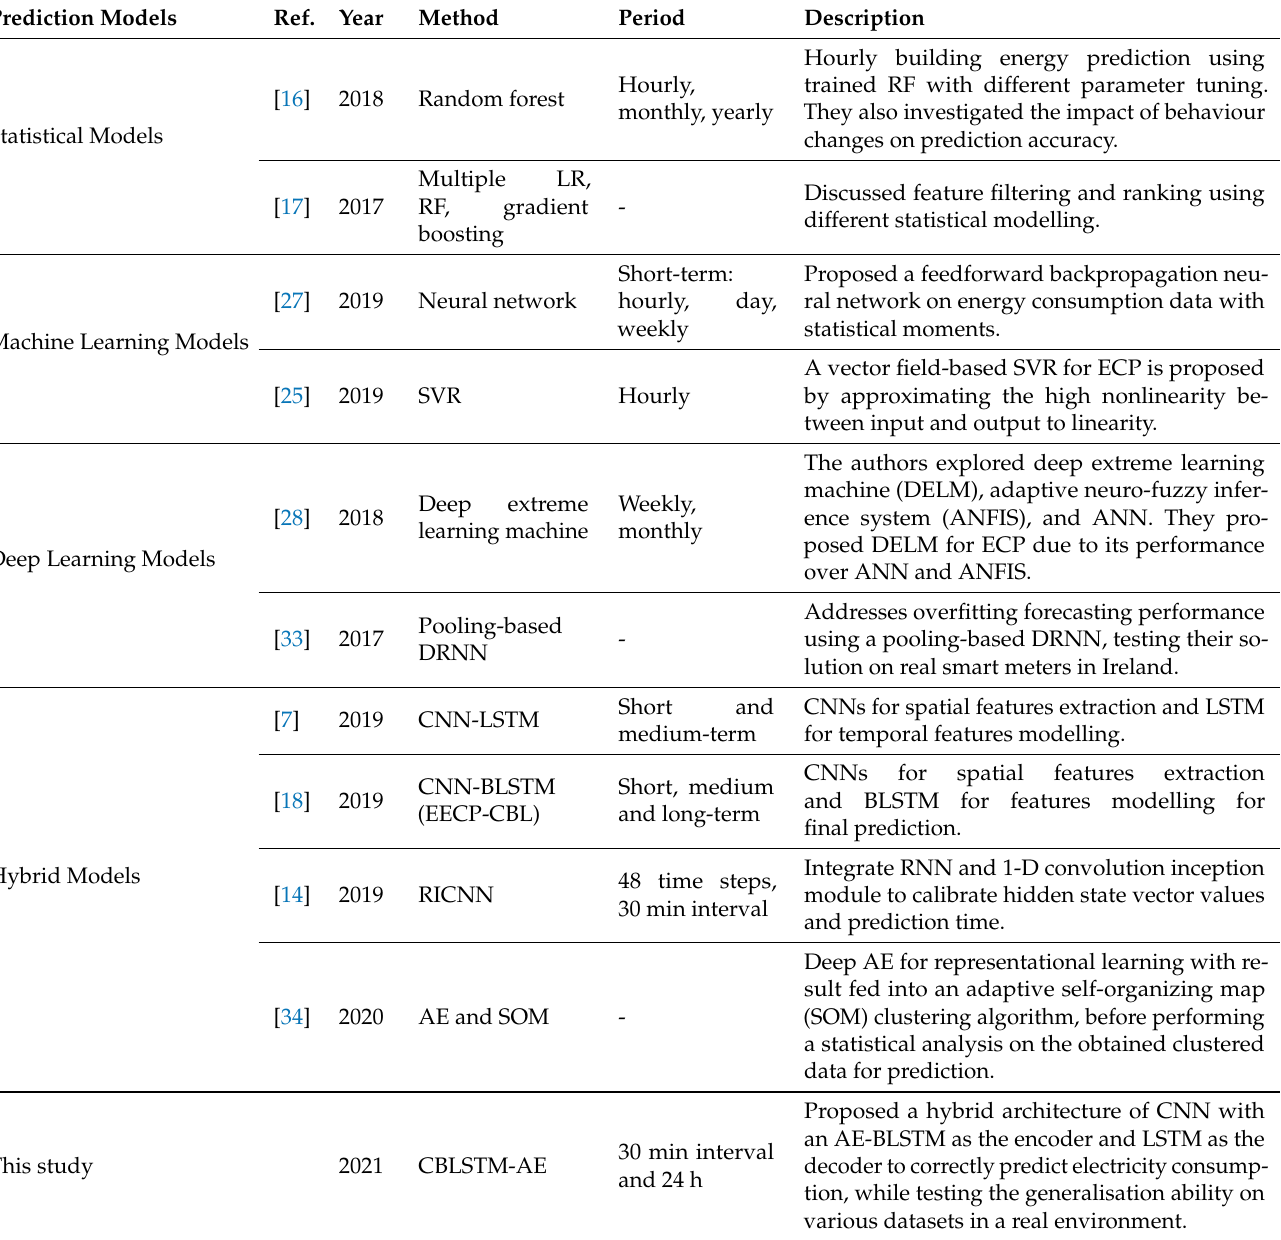
Table 1. Comparative summary of prediction frameworks for energy